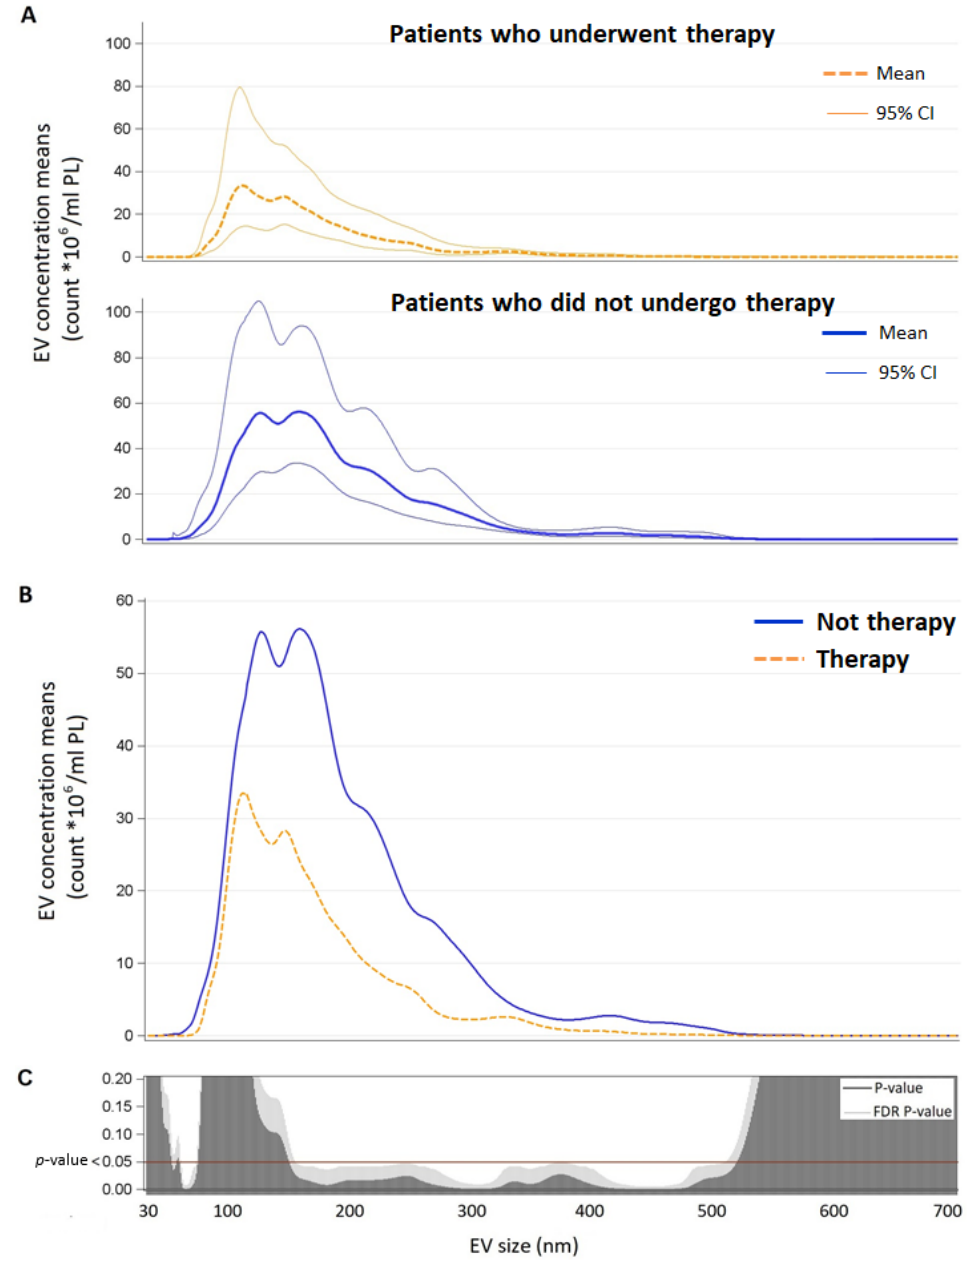
Figure 2. Panel A: EV concentration means and confidence intervals for each EV size (nm) in patients who underwent therapy and patients who did not undergo therapy. Panel B: direct comparison between EV concentration means for each size (nm) by therapy ( n = 18). Panel C: p -value and False Discovery Rate p -value for each size are reported. Abbreviations: EV, extracellular vesicles.